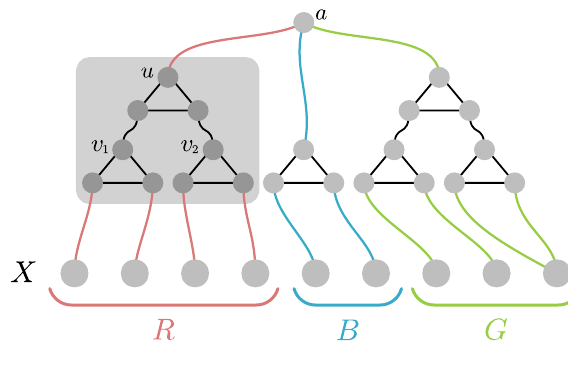
Figure 1. The gadget ◦ Γ X for X = { R , G , B }